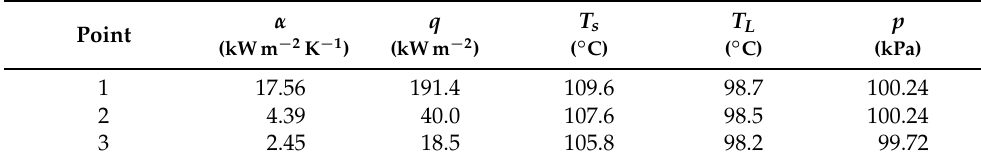
Table 5. Water boiling data used for estimation of measurement